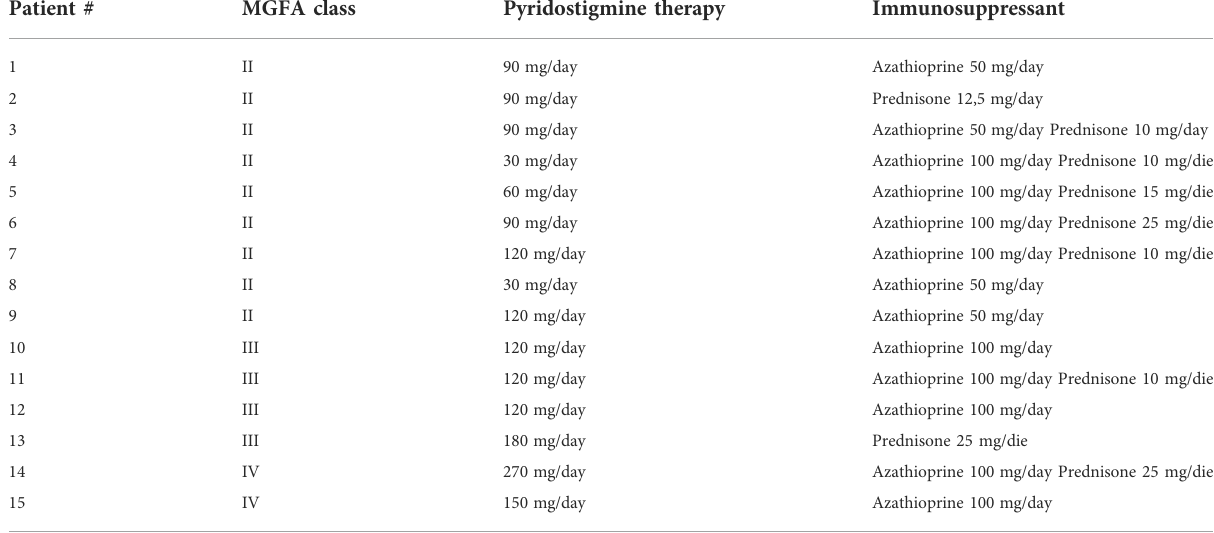
TABLE 1 – daily total posology of pyridostigmine and immunosuppressant therapy of the patients enrolled in the study. Patient